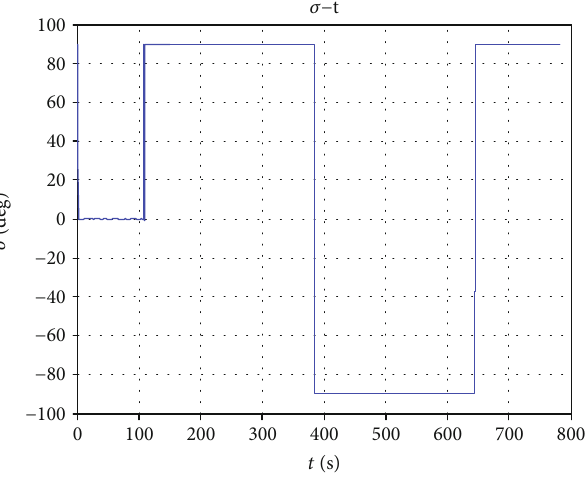
Figure 11: Bank angle σ with time t